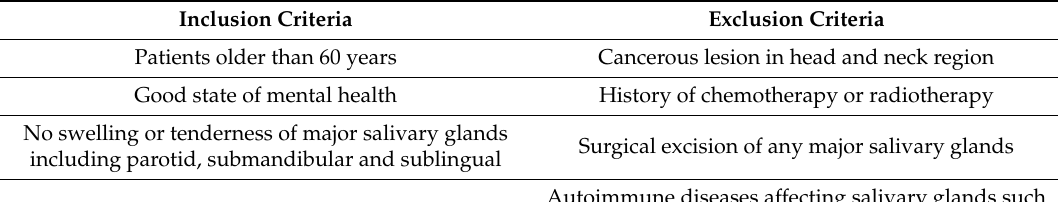
Table 1. The selection criteria used for recruiting patients for this